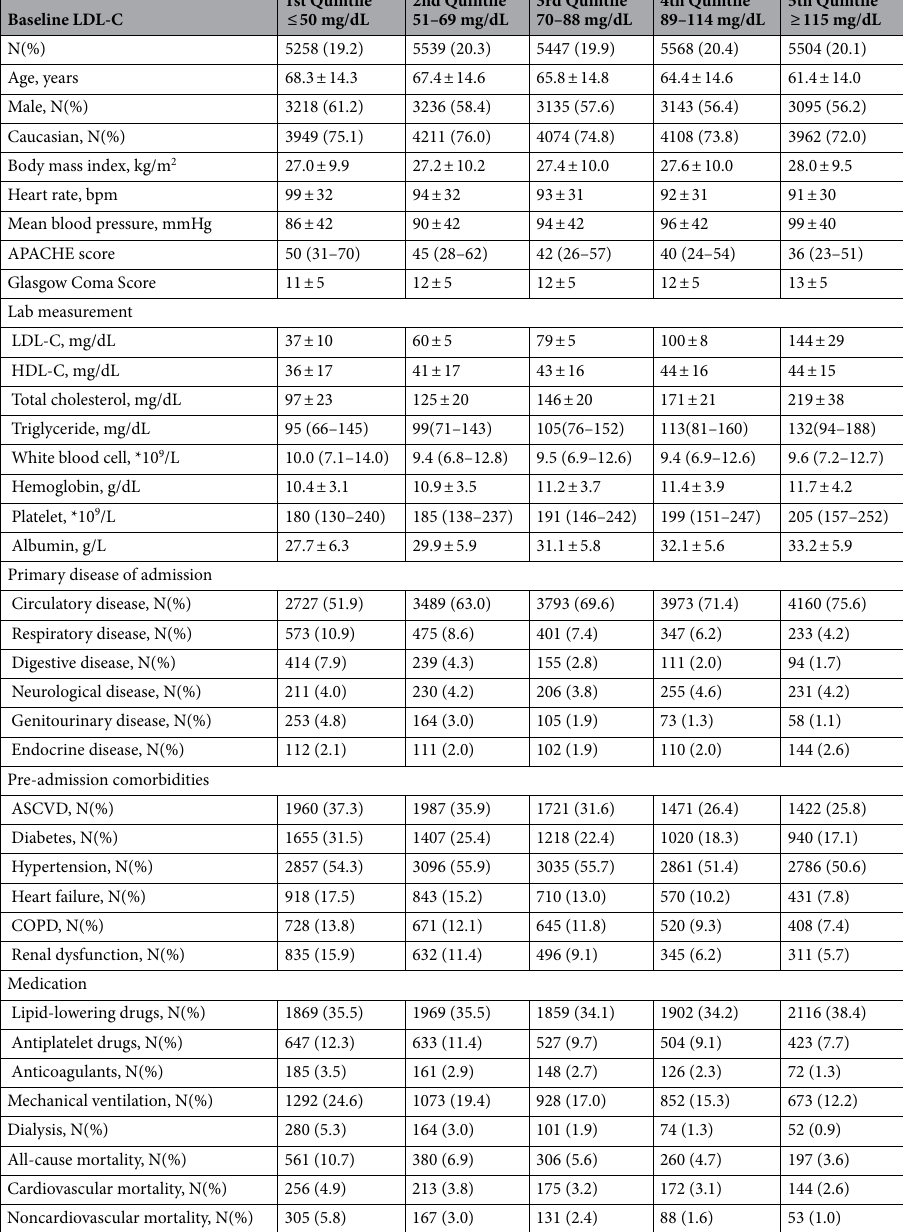
Age, and Chronic Health Evaluation score; ASCVD, atherosclerosis cardiovascular diseases; COPD, chronic obstructive pulmonary